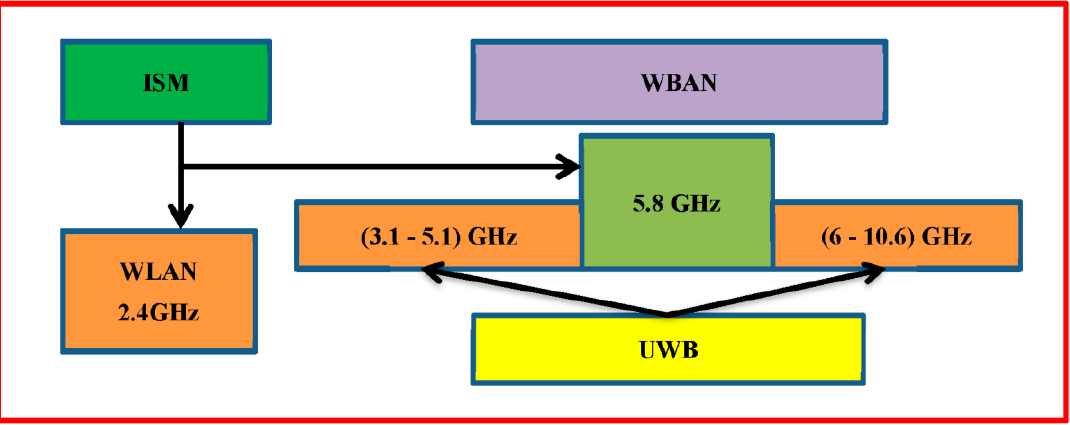
Figure 3. WBAN and Ultra-Wide Band (UWB) Spectrum.